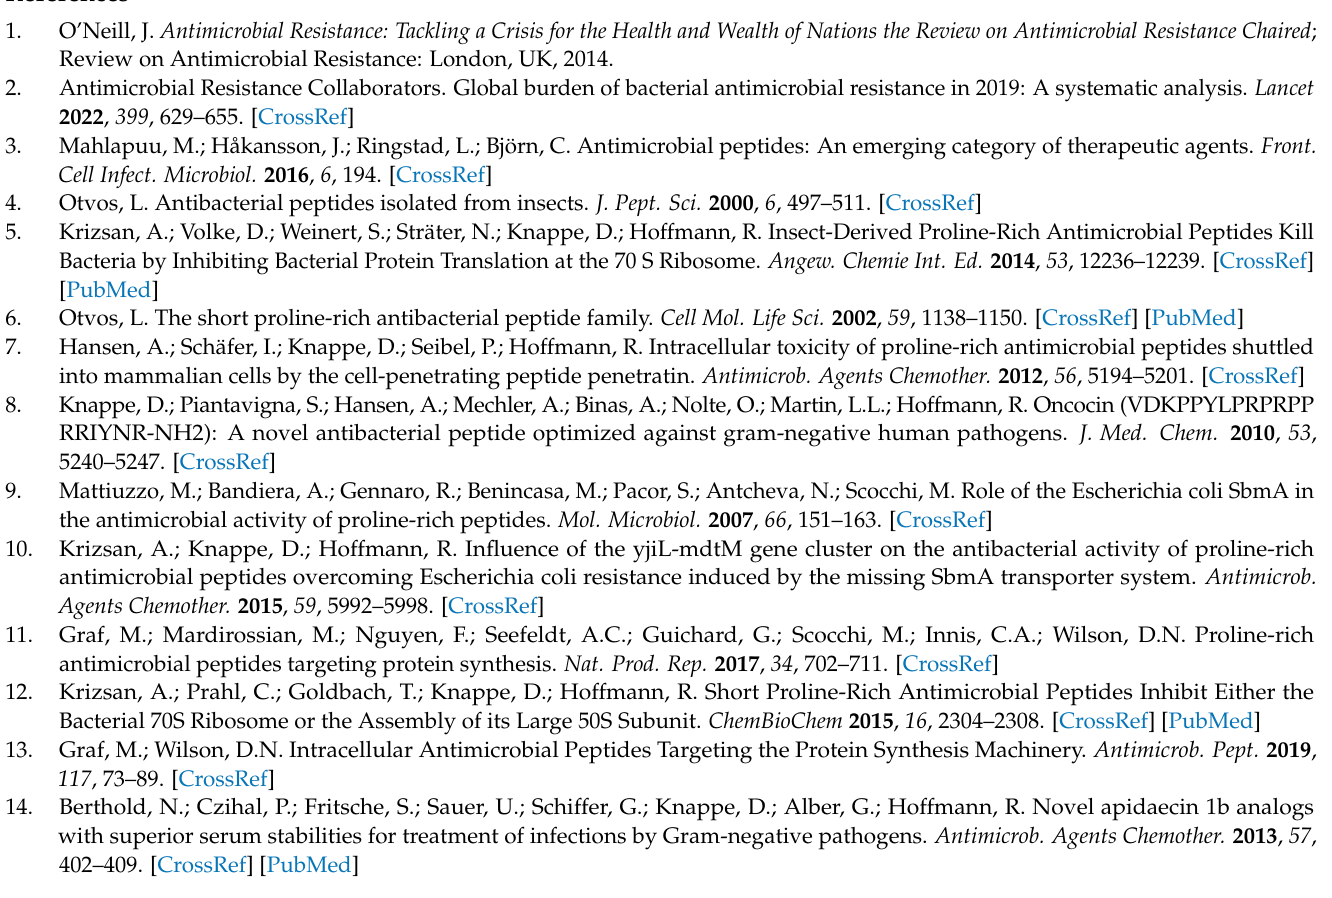
used in this study. Table S4: T -test calculations for the sample set of the in vitro translation of GFP with RF1 in the presence of PrAMPs using an unpaired two-tailed T -test to judge the significance. Table S5: T -test calculations for the sample set of the in vitro translation of GFP without RF in presence of PrAMP using an unpaired two-tailed T -test to judge the significance. Table S6: T -test calculations for the uptake experiments of cf-labeled PrAMP into E. coli BW25113 and Rosetta pLyS using an unpaired two-tailed T -test to judge the